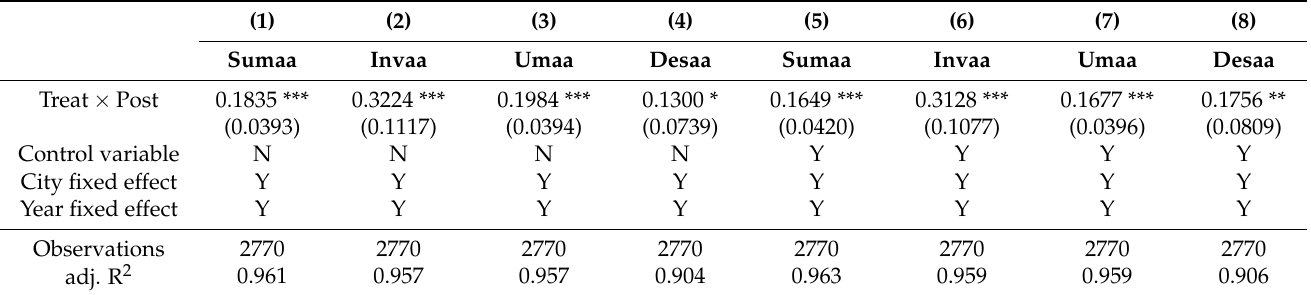
Table 3. Benchmark regression